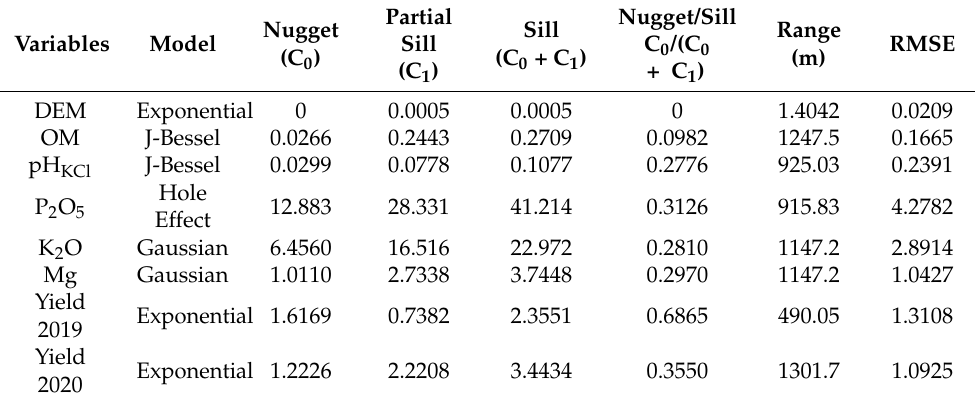
Table 4. Semi-variogram parameters of DEM, soil attributes and wheat